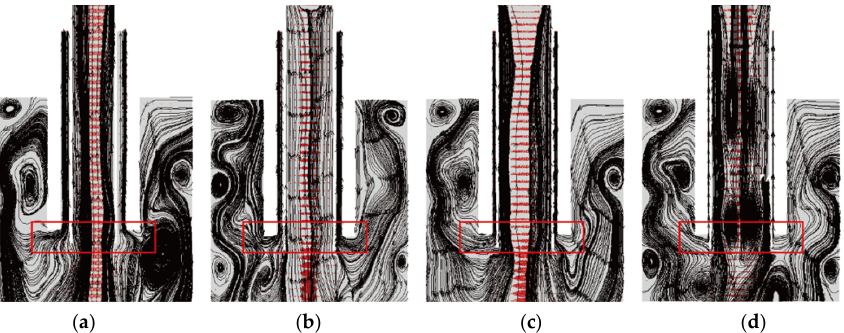
Figure 10. The movement track of liquid under different internal vortex-finder diameters. ( a ) 0.64D ( b ) 0.72D ( c ) 0.80D ( d ) 0.88D.